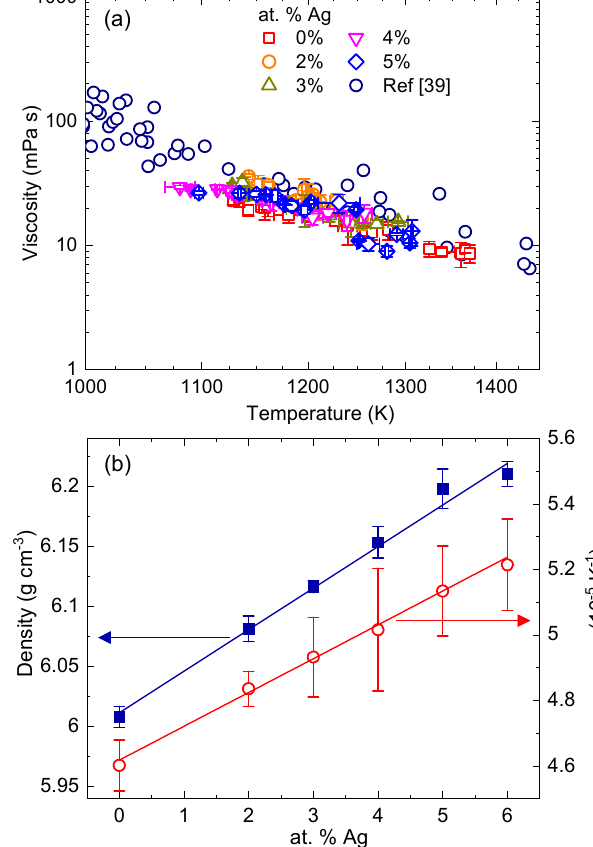
Figure 5. ( a ) Viscosity of (Ti 35.2 Zr 43.8 Ni 21 ) 100 − x Ag x alloy liquids as a function of temperature. ( b ) Density (left) and thermal expansion coefficient α T (right) of (Ti 35.2 Zr 43.8 Ni 21 ) 100 − x Ag x alloy liquids as a function of Ag concentration at their respective T l .